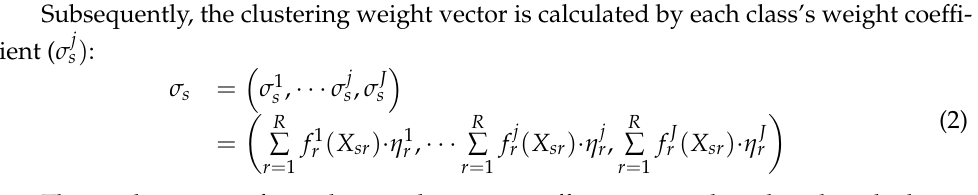
Figure 4. The typical r th criterion j th sub-class whitenization weight function.